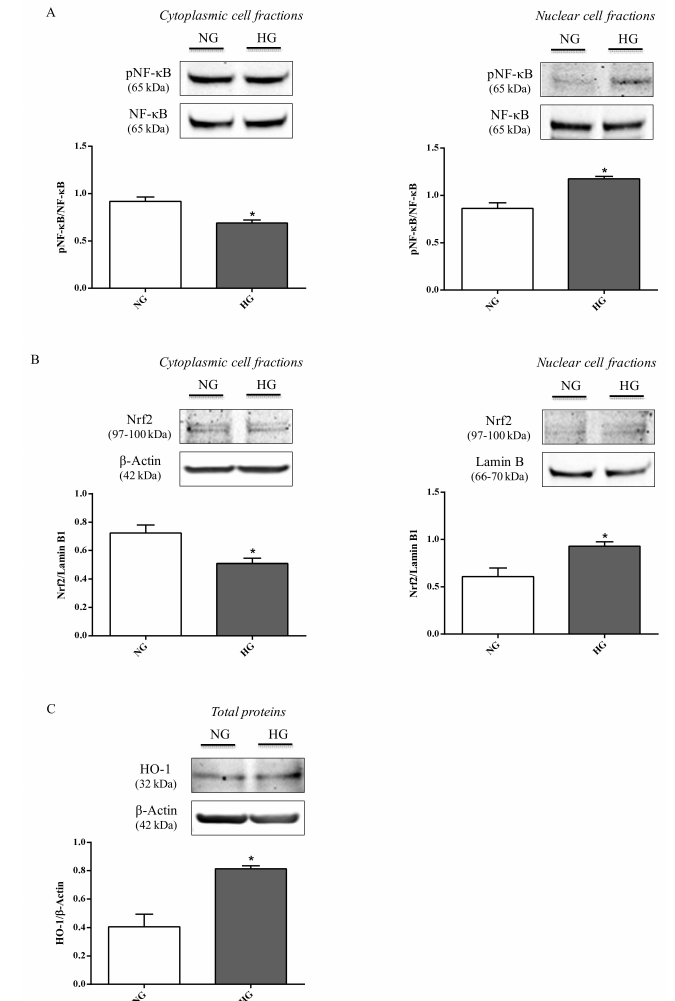
Figure 6. Representative immunoblots of ( A ) cytoplasmic and nuclear pNF- κ B, ( B ) cytoplasmic and nuclear Nrf2, and ( C ) total HO-1 in protein extracts from astrocytes subjected to normal or high glucose conditions for 48 h. NG = normal glucose condition (5 mM); HG = high glucose condition (40 mM). Histograms refer to the means ± SD of three independent experiments. Statistical analysis was performed using Student’s t-test. The densitometric values of cytoplasmic and nuclear pNF- κ B bands were normalized against total NF- κ B. The densitometric values of cytoplasmic Nrf2 and total HO-1 bands were normalized against β -actin, while densitometric values of nuclear Nrf2 bands were normalized against lamin B1. * p < 0.05 vs.